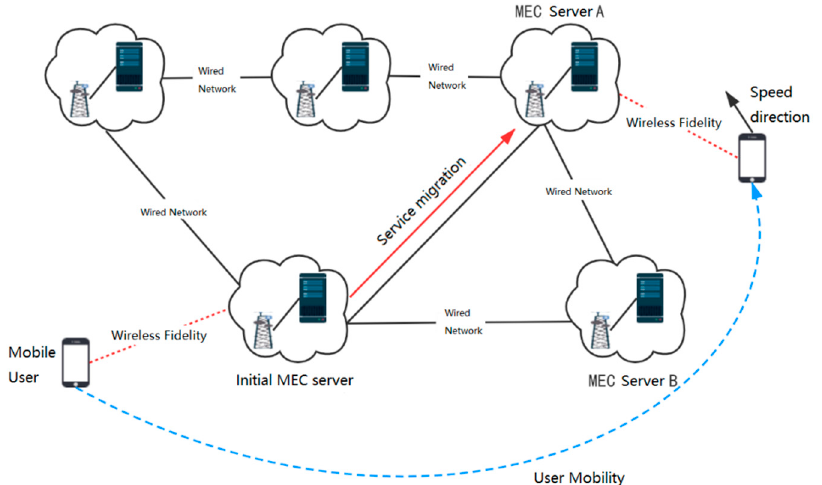
Figure 1. VM migration scenario.